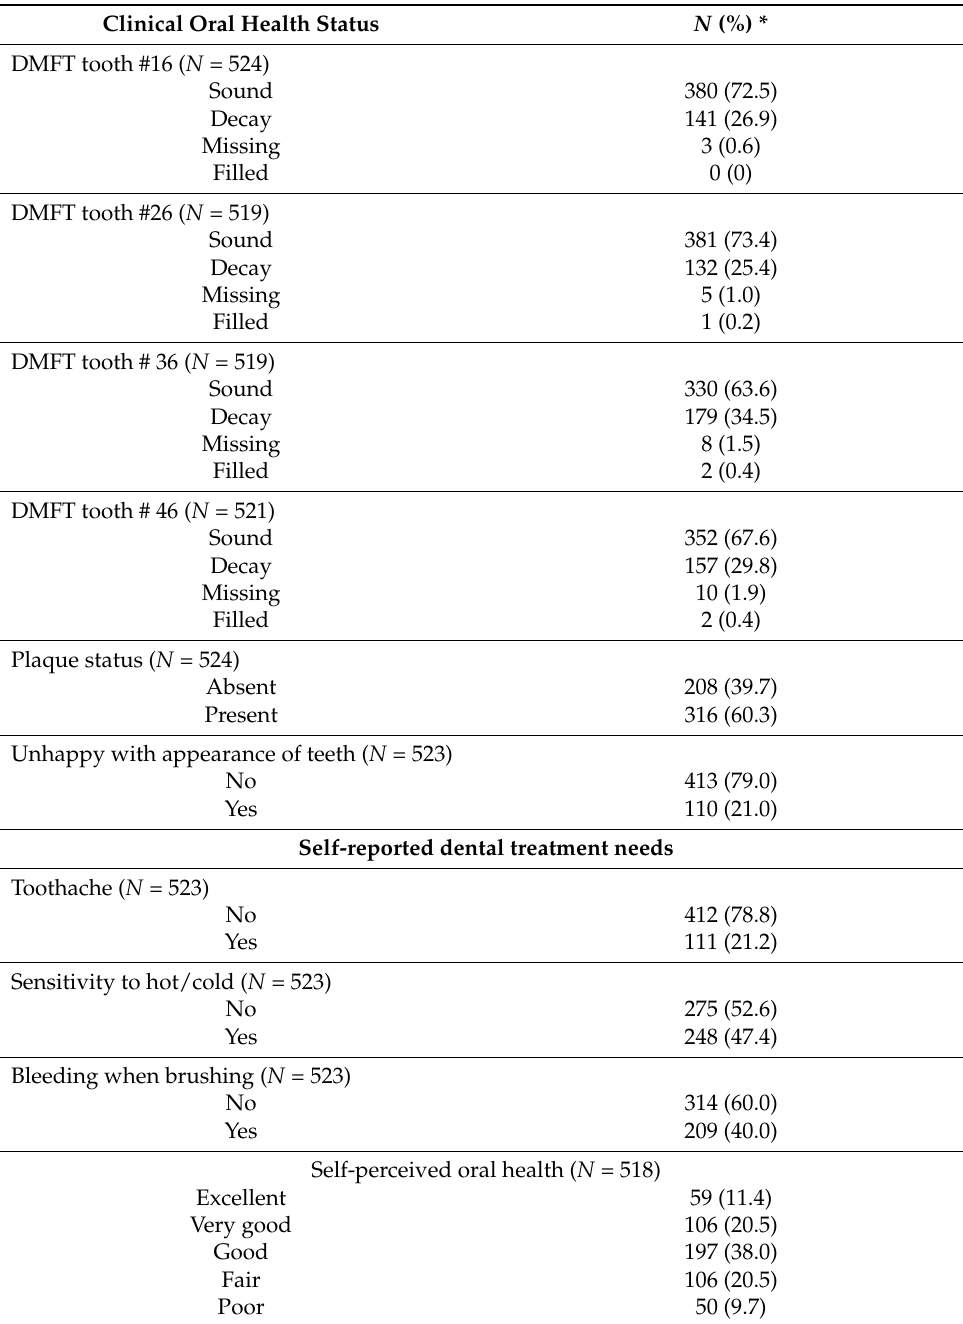
Table 2. Descriptive results of oral health status of adolescents in Lesotho ( N =